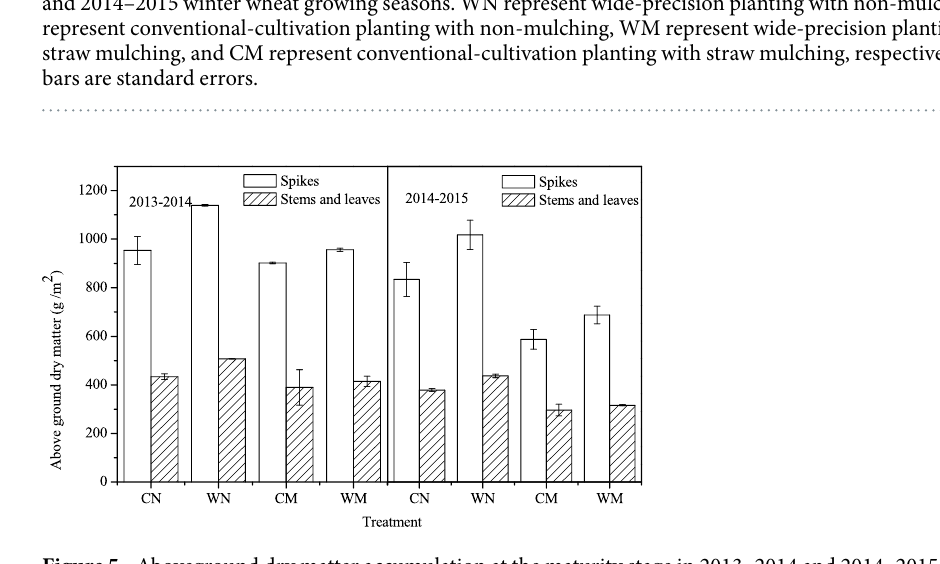
Figure 5. Aboveground dry matter accumulation at the maturity stage in 2013–2014 and 2014–2015 winter wheat growing seasons. WN represent wide-precision planting with non-mulching, CN represent conventional- cultivation planting with non-mulching, WM represent wide-precision planting with straw mulching, and CM represent conventional-cultivation planting with straw mulching, respectively. Vertical bars are standard